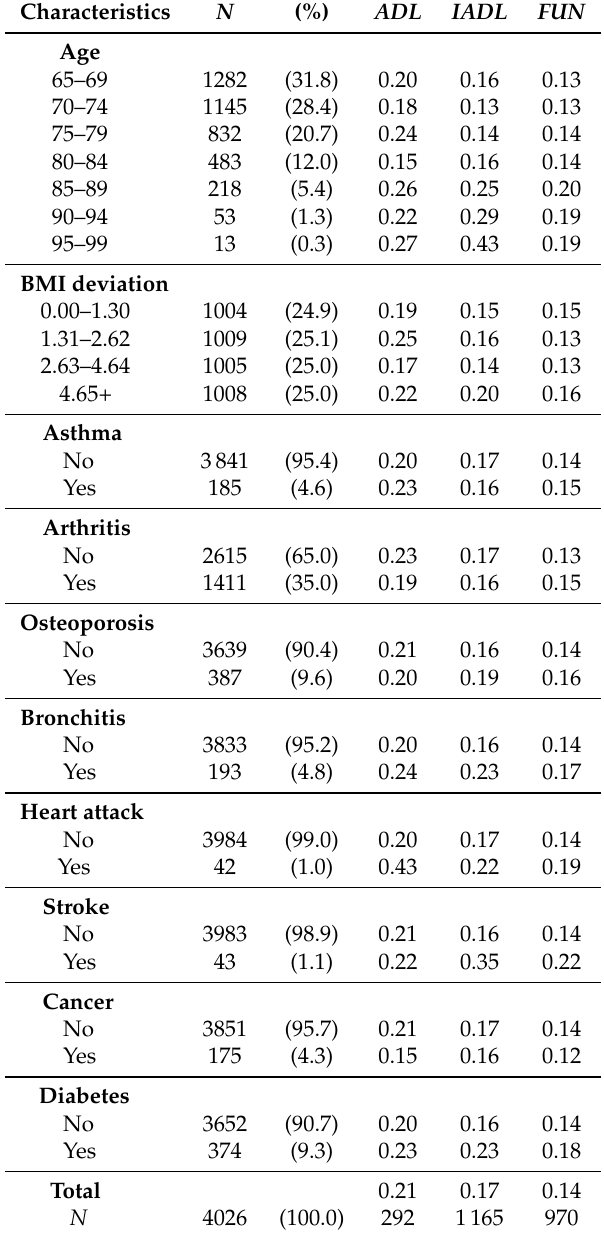
Table 1. Descriptive statistics of the exogenous characteristics affecting dependence.